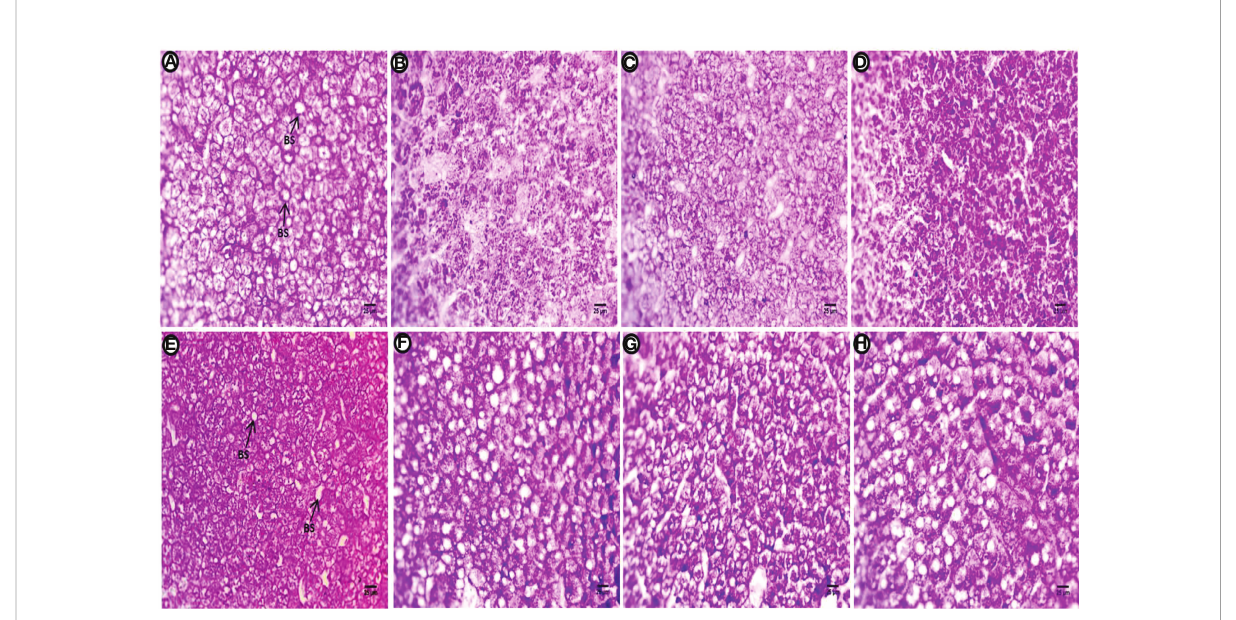
FIGURE 7 Sections of the liver (PAS reaction showing polysaccharides) of common carp showing the control group, and after treatment with 10 mg/L PE- MP, 10 mg/L PE-MPs + 200 µg/L 4-NPgroup, and 200 µg/L 4-NPgroup, as (A – D) for 2 weeks of exposure and (E – H) for 2 weeks of post exposure, respectively. Blood sinusoids